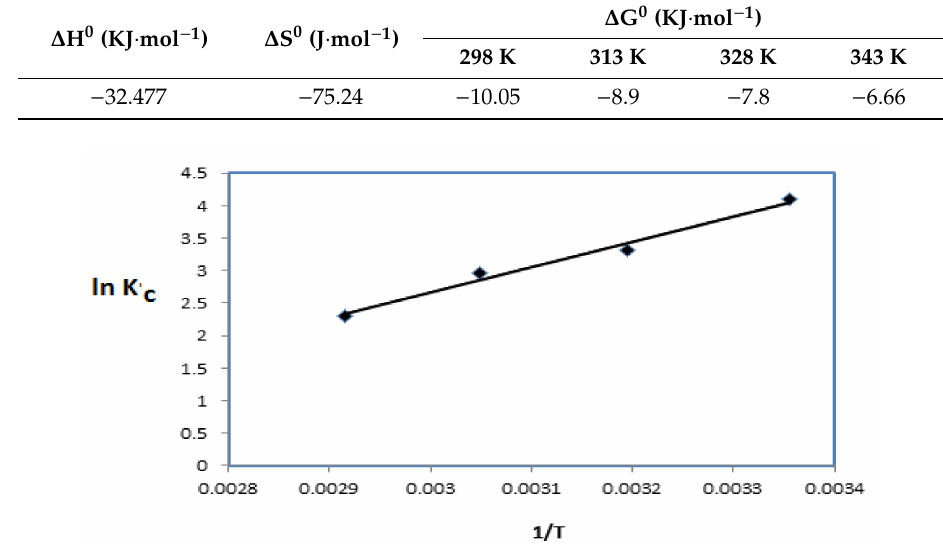
Table 3. Thermodynamic parameters of QVP / AAm-Fe 3 O 4 for removal of CR from aqueous solution at di ff erent temperatures.